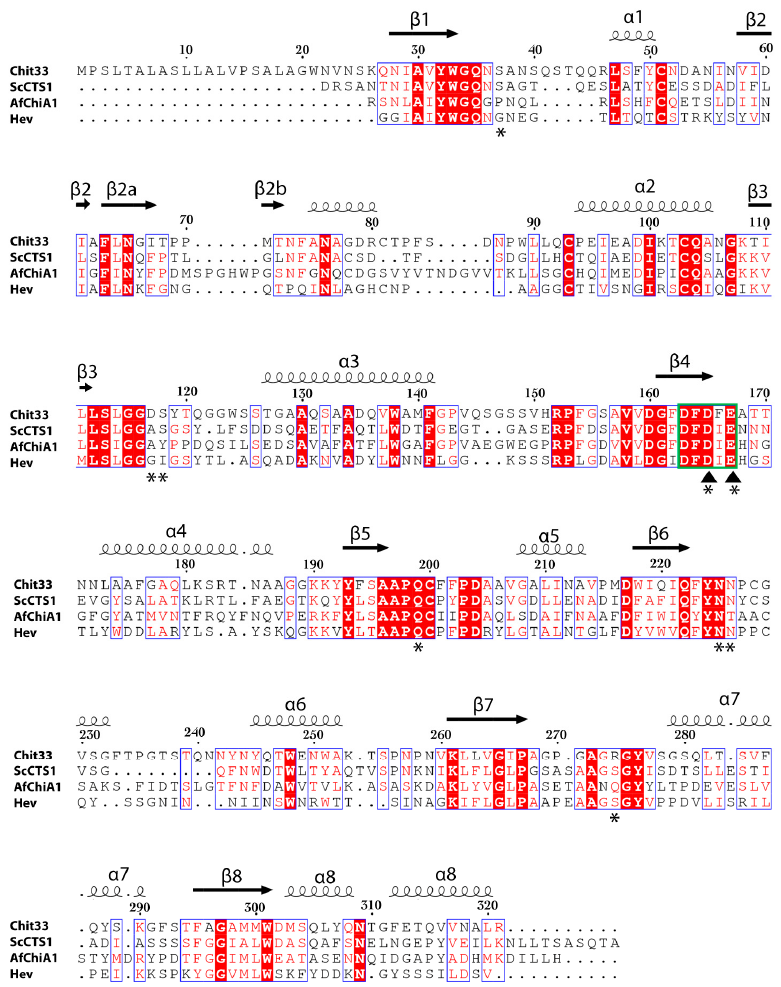
Figure 2. Sequence alignment of Chit33 with homologues. Sequences from the fungal chitinases from S. cerevisiae (ScCTS1) (PDB code 2UY2), A. fumigatus (AfChiA1) (PDB code 4TX6) and the plant chitinase hevamine from Hevea brasiliensis (PDB code 1HVQ) are shown (ESPript—http://espript.ibcp.fr, accessed on 8 October 2020). The DxDxE motif is boxed in green. Inverted triangles indicate catalytic residues, and asterisks mark residues mutated in this this work.